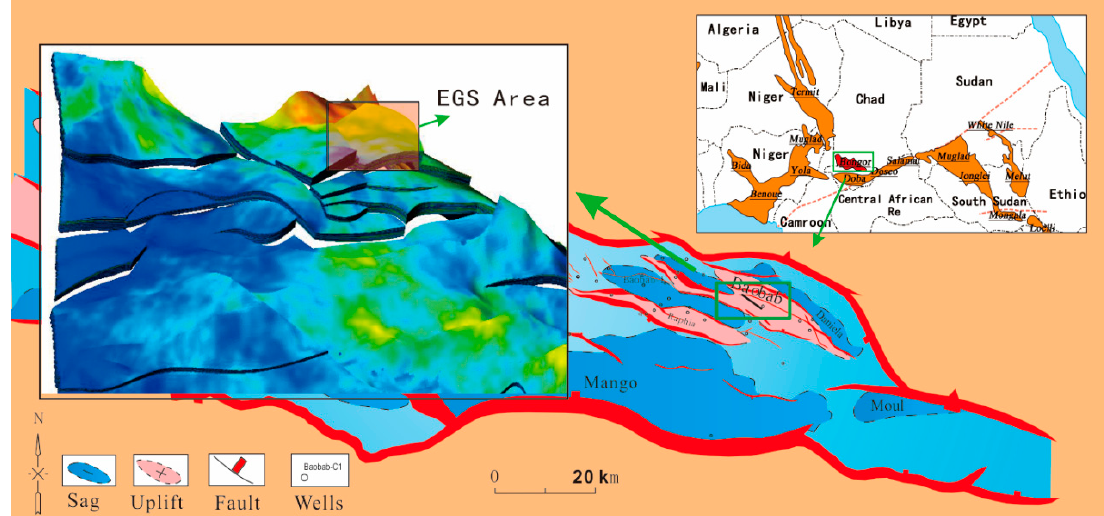
Figure 1 . Bongor basin location [17], structural sketch map of the basin and geologic model.